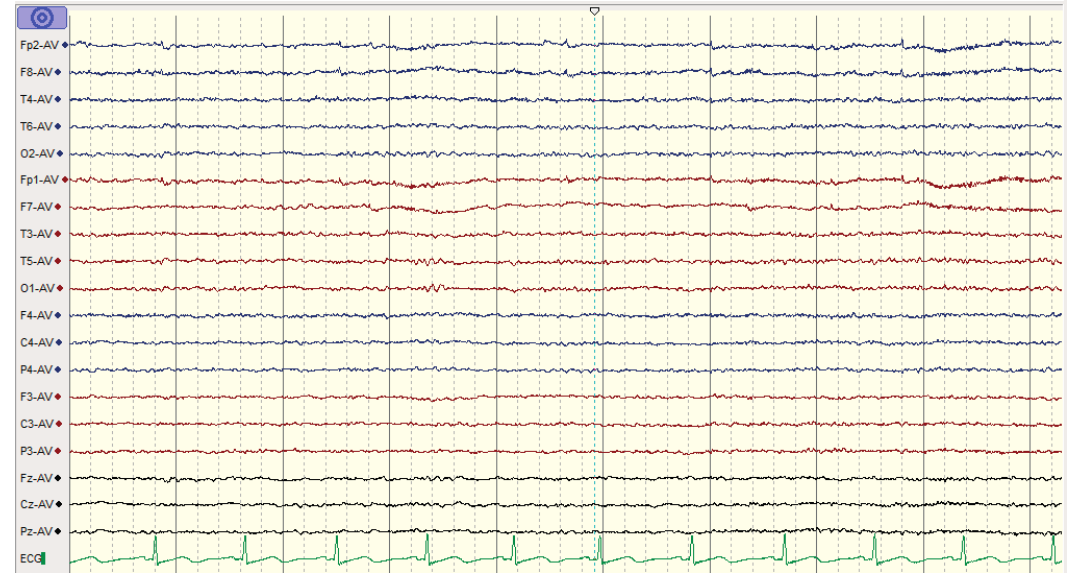
Figure 3. The EEG activities for a healthy subject during a working memory task using the NicoletOne systems